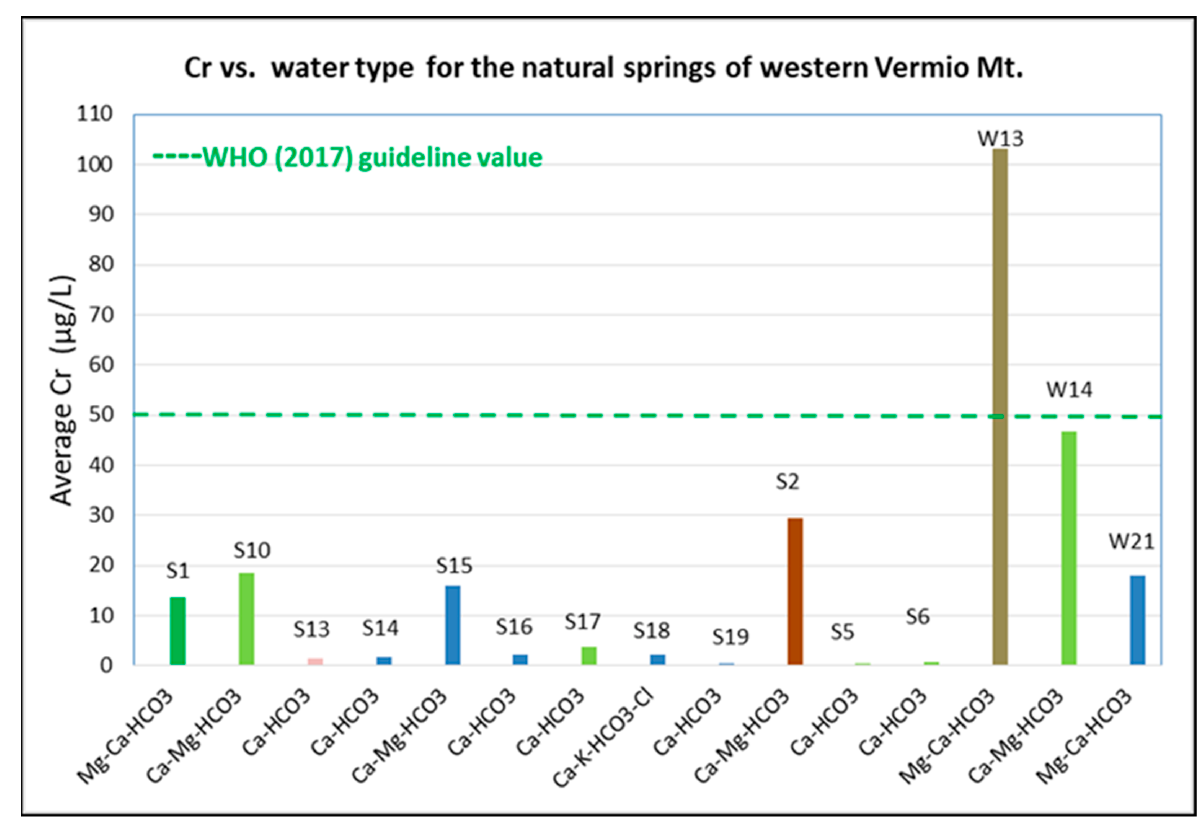
Figure 15. Average concentrations of Cr vs. water types of the natural springs in western Vermio Μ t.